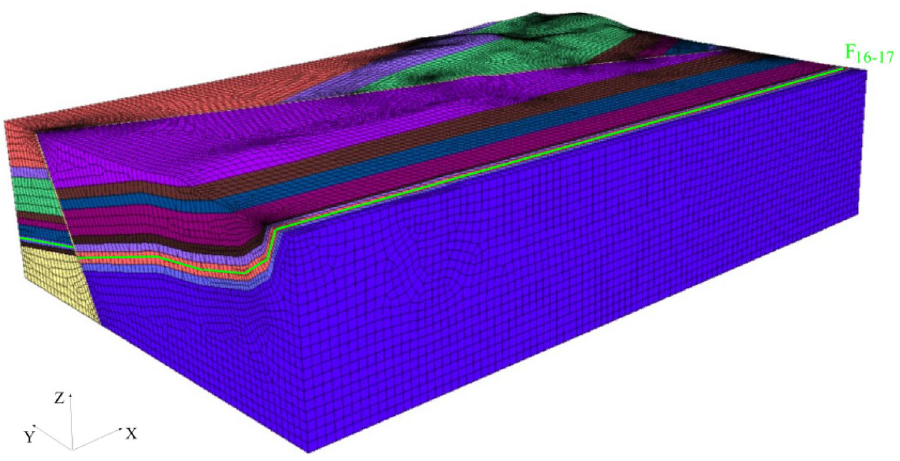
Figure 6. Imported model in FLAC 3D .